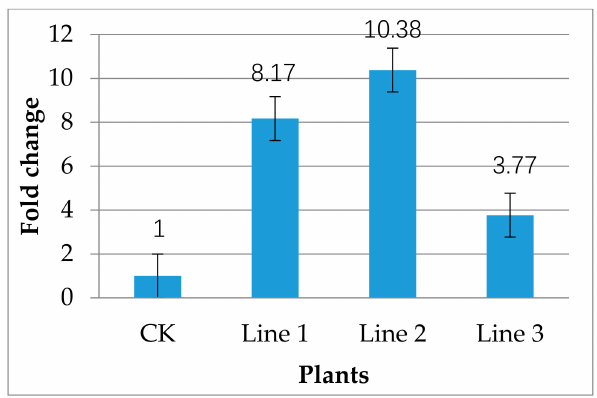
Figure 6. RT–PCR-mediated expression level analysis of CsDMR6 in transgenic plants. Results were expressed as mean ± standard error of three independent